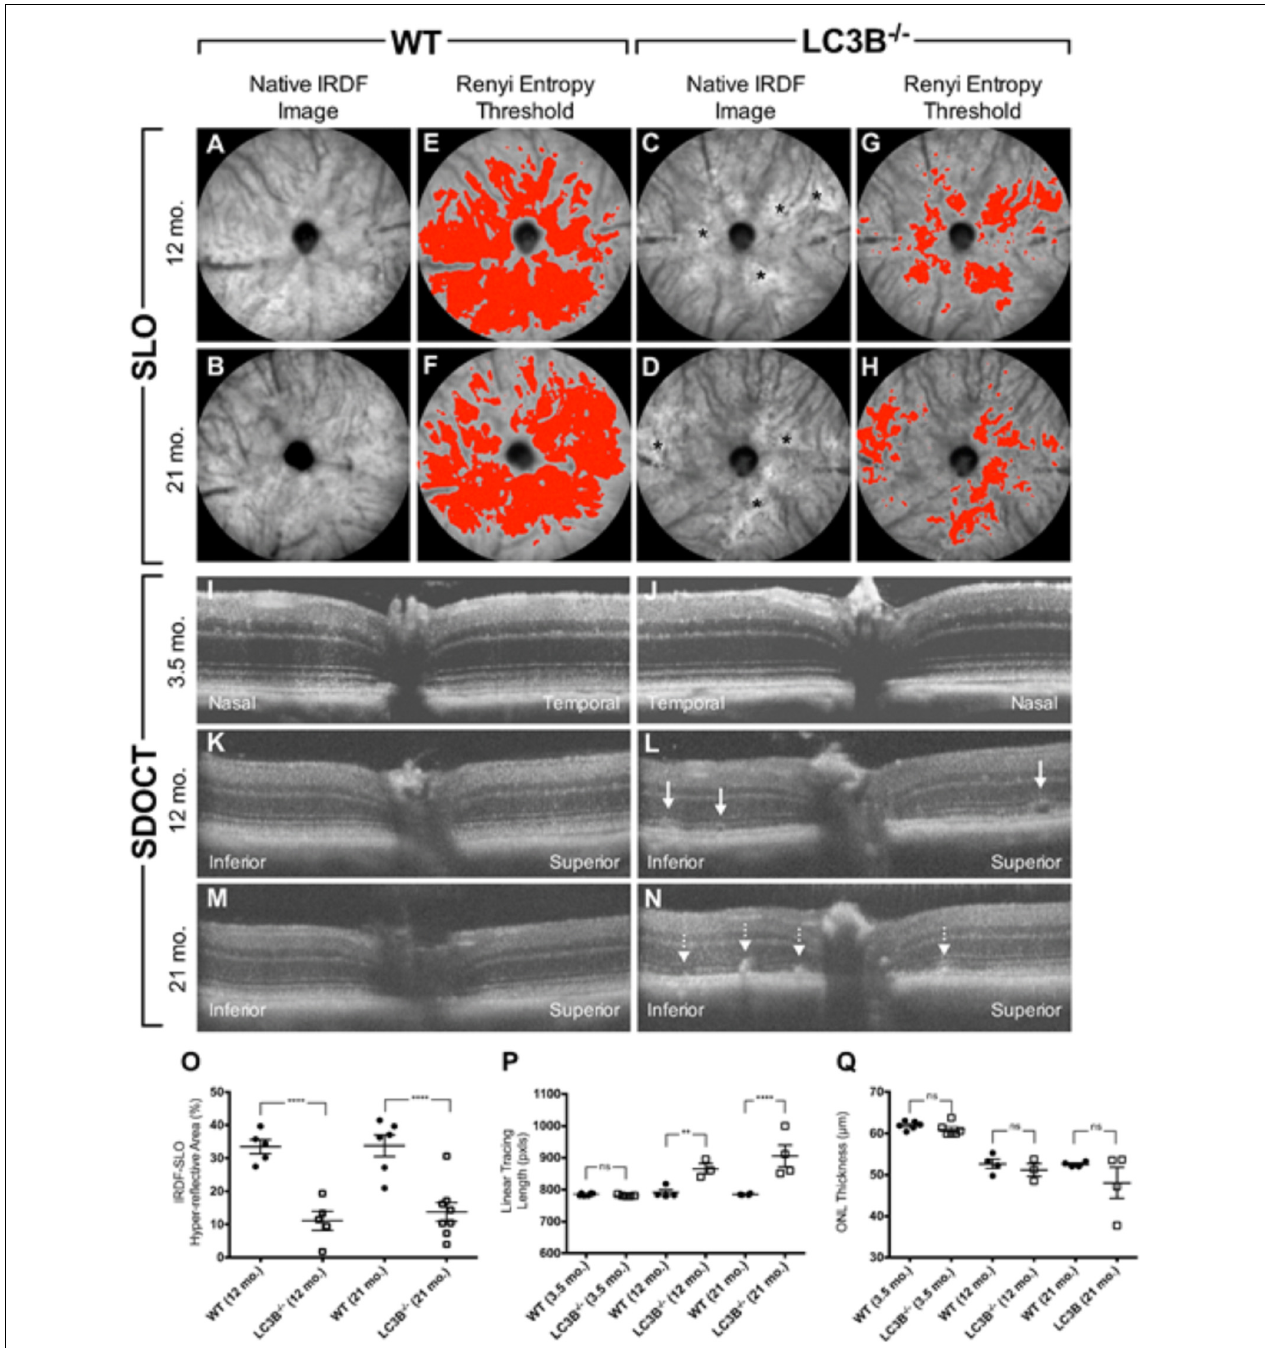
FIGURE 2 | Representative SLO (A–H) and SDOCT (I–N) images from young (3.5 months old) or aged (12 and 21 months old) L3CB − / − mice compared to age-matched WT controls. Quantified imaging results for hyper-reflective features observed by IRDF-SLO (O) and SDOCT (P,Q) . Native IRDF-SLO images in fundus architecture in WT (A,B) and L3CB − / − (C,D) , note irregular white patches, black asterisks in the LC3B − / − ; A Renyi threshold applied to the SLO images captures the level of homogeneity, or inhomogeneity, in the hyper-reflective area for WT (E,F) and L3CB − / − (G,H) mice, respectively. SD-OCT: WT (I,K,M) and 3.5 months old LC3B − / − (J) have normal architecture whereas the older L3CB − / − (L–N) examples have localized disruptions within the photoreceptor-attributable layer, immediately adjacent to the RPE. Sub-retinal vacuoles ( L ; solid line arrows) and hyper-reflective pathology ( N ; dotted line arrows) observed in the photoreceptor layer of 12 and 21 months old L3CB − / − examples relative to WT controls (K,M) . The linear tracing length analysis (P) captures the presence or absence of suspected abnormal pathology in the photoreceptor/RPE region between L3CB − / − and WT. SDOCT image depth is 0.42 mm (I–N) . Graphical data (O–Q) shown as mean ± SEM: ns = p > 0.05, ∗ p < 0.05, ∗∗ p < 0.01, ∗∗∗ p < 0.001, and ∗∗∗∗ p < 0.0001. N = 6 (3.5 months WT and LC3B − / − ), 4 (12 months WT), 3 (12 months LC3B − / − ), and 4 (21 months WT and LC3B − / − ).